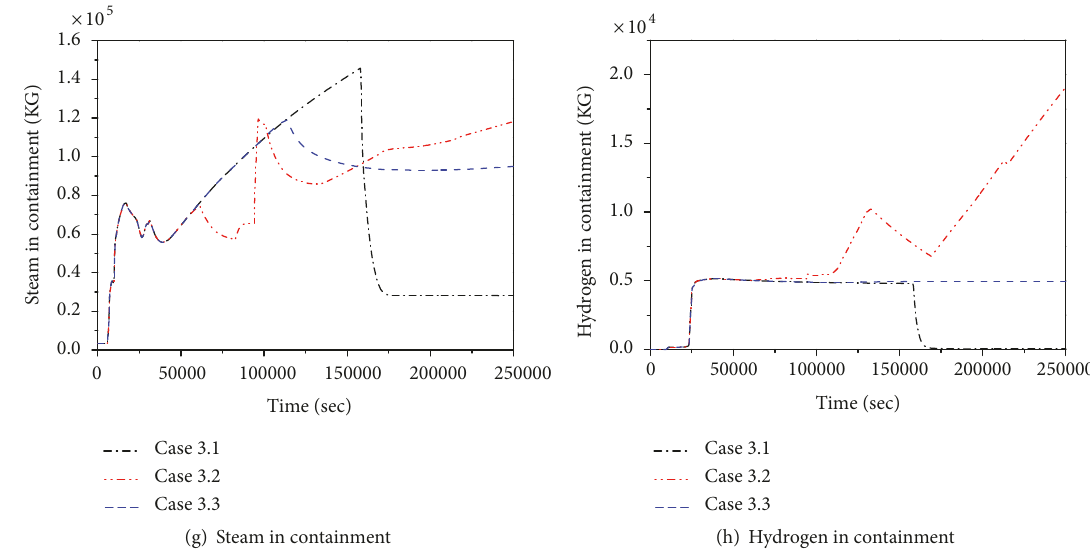
Figure 11: Effect of injection